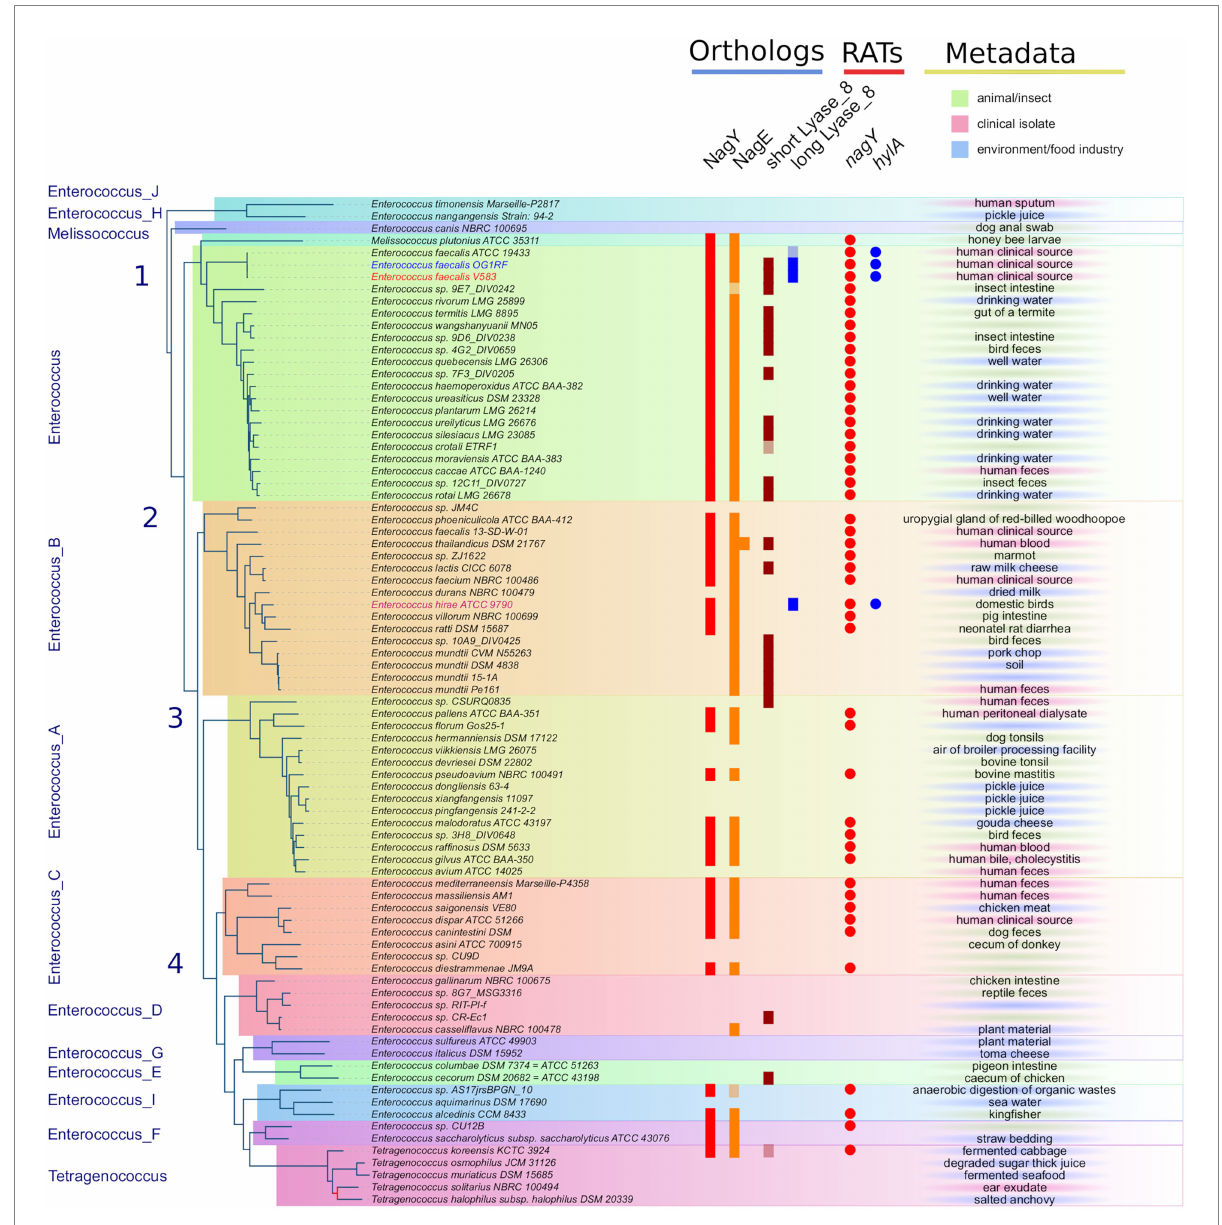
FIGURE 3 Distribution of NagY, NagE, and HylA protein families in Enterococcaceae genomes. First panel on the left: The Enterococcaceae species tree inferred with the 526 orthologous gene (OGs) clusters present in at least 95% of the genomes. The tree was rooted with Marseille-P2817 strains (Supplementary Material and Methods). The 13 family genera of Enterococcaceae described in the GTDB and the four phylogenetic groups described in Lebreton et al. (2017) were reported. The tree is perfectly resolved except for one branch of the Tetragenococcus subtree colored in red (13.1/54, ufboot/alrt supports). Second panel in the middle-left (“Orthologs”): distribution of orthologous proteins to NagY, NagE, and short and long Lyase_8 forms. Lightened colors indicate the presence of pseudogenes. Third panel in the middle-right (“RATs”): occurrence of RAT sequence in front of nagY and hylA genes. Last column on the right (“Metadata”): metadata available in GenBank files of the analyzed